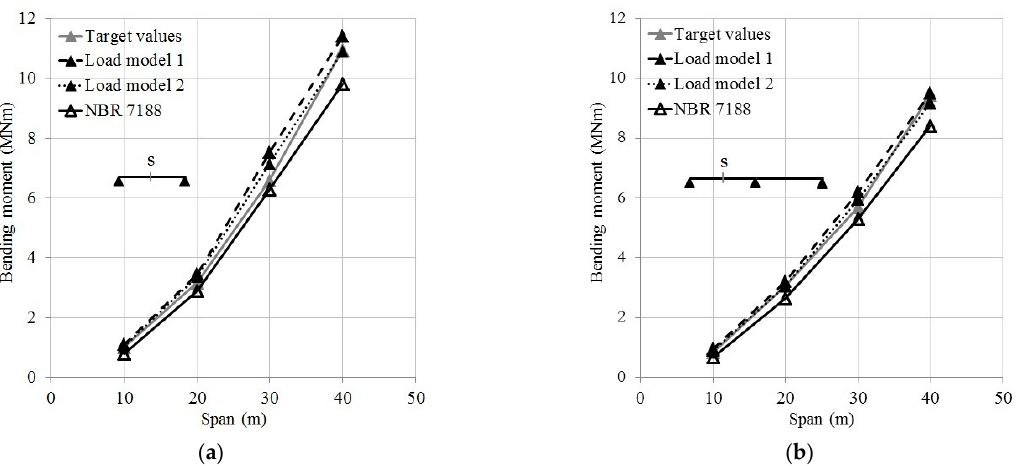
Figure 10. Comparison between the effects generated by the load models and the target values. ( a ) Positive moments on simply supported bridges. ( b ) Positive moments on continuous bridges.